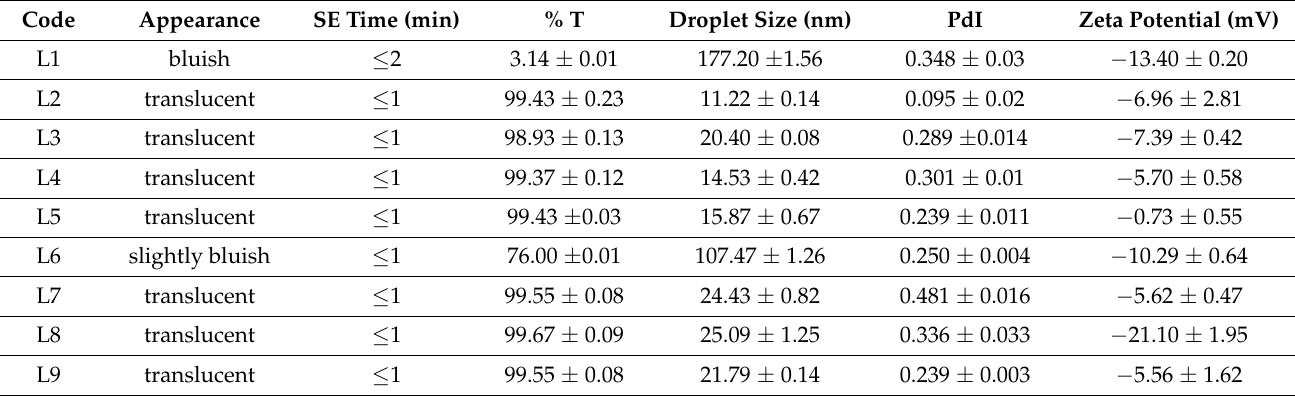
Table 6. Characterization of blank SEDDS after dilution (1:100) in distilled